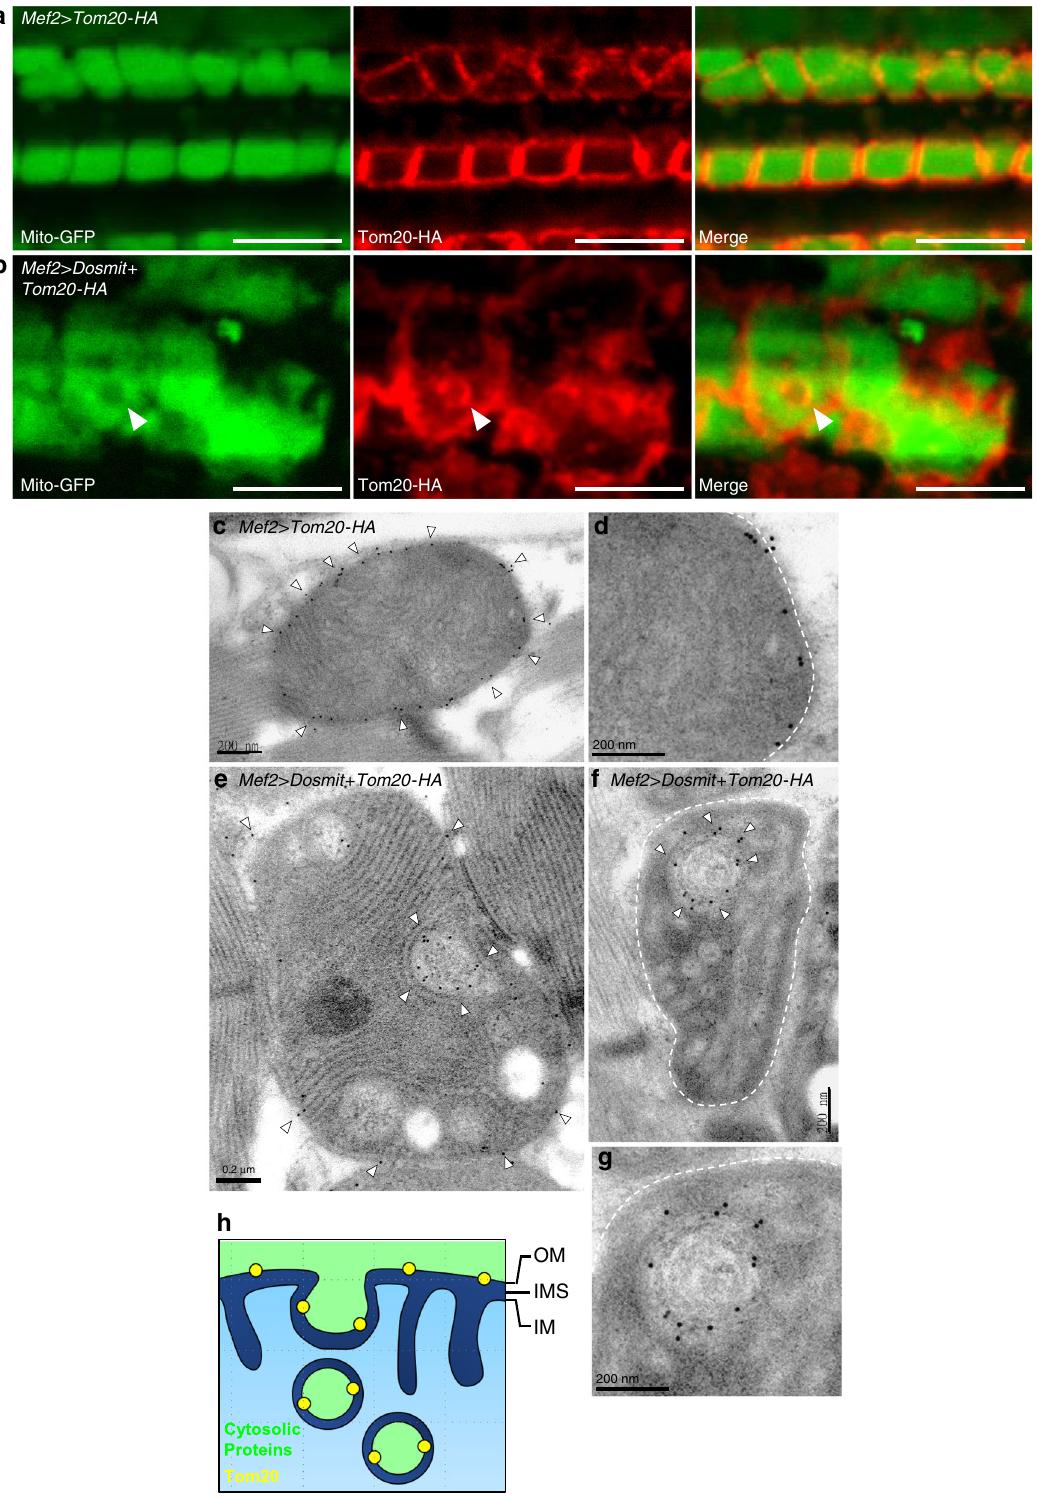
Fig. 6 Ectopic expression of Dosmit induces the formation of intramitochondrial vesicles containing Tom20. a Confocal microscopy images showing the HA-tagged outer mitochondrial membrane protein, Tom20-HA (red), localized on the outer region of mitochondria in fl ight-muscle tissue from Mef2 > Tom20 fl ies in which mito-GFP (green) was also expressed. b In Mef2 > Dosmit + Tom20-HA fl ies that also expressed mito-GFP, Tom20-HA (red) localized on the membranes of intramitochondrial vesicles (arrowheads). Scale bar: 5 μ m. c TEM images showing that gold-labeled Tom20-HA only localized on the outer mitochondrial membrane in the fl ight muscles of control fl ies (arrowheads). d Magni fi ed image of c . e , f TEM images of gold-labeled Tom20-HA localizing primarily on the membranes of intramitochondrial vesicles (arrowheads) in the fl ight muscles of Mef2 > Dosmit + Tom20-HA fl ies in which Dosmit was ectopically expressed. Scale bar: 200 nm. g Magni fi ed image of f . h Working model of cytosolic protein uptake and intramitochondrial vesicle formation (OM outer mitochondrial membrane, IMS intermembrane space, IM inner mitochondrial